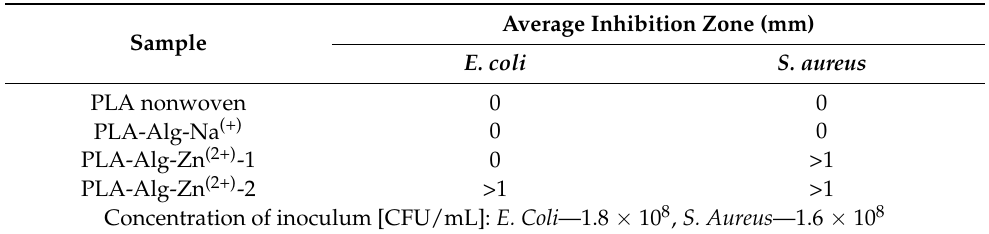
Table 6. Antibacterial activity results according to standards EN-ISO 20645:2006 of PLA-Alg-Zn (2+) composites